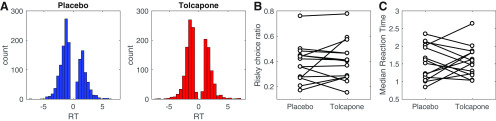

A, Overall RT distributions for placebo (blue) and tolcapone (red). Here, positive RTs reflect choices of the risky option, and negative RTs reflect choices of the safe option. B, Proportion of choices of the risky option RT per participant and drug condition. C, Median RT per participant and drug condition.